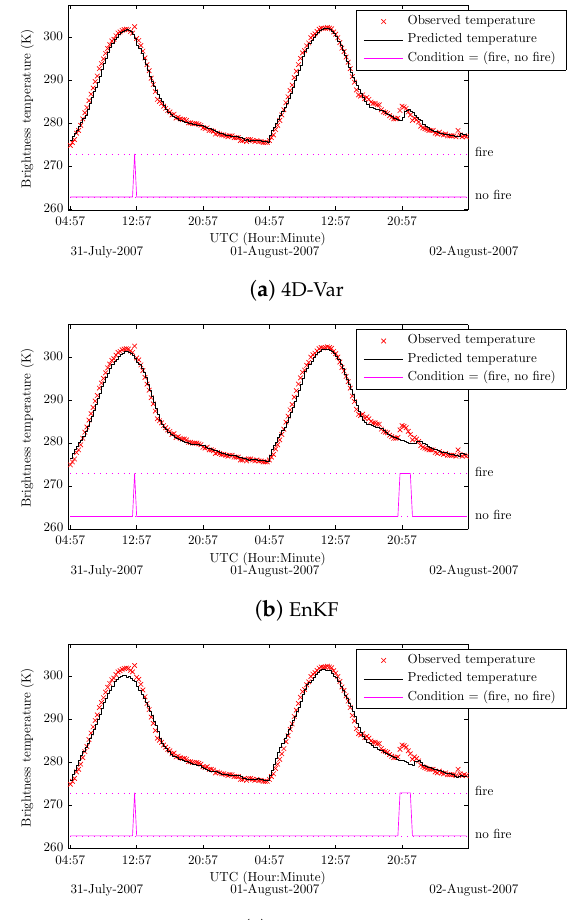
Figure 7. Example of a detection of a brief night fire reported by MODIS MOD14/MYD14 . Level 1.5 pixel at ( 983,901 ) (Line, Column) with pixel center at ( 25.6083 ◦ S,31.2846 ◦ E ) . Detection at 10 − 3.5